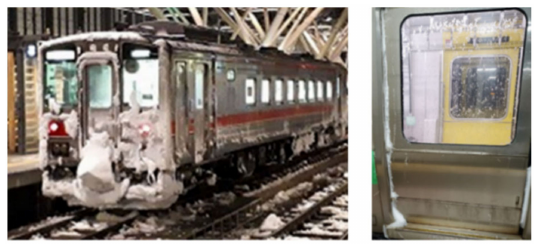
Figure 1. Snow accumulation conditions.